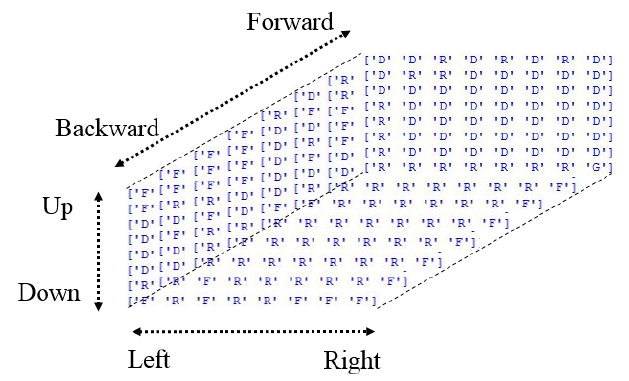
Figure 9. Real ‐ world test: ( 1 ) The robot starts moving from the start point (Sphere). ( 2 – 8 ) The robot track the found path while avoiding the obstacle. ( 9 ) The robot reaches the target (Cube).